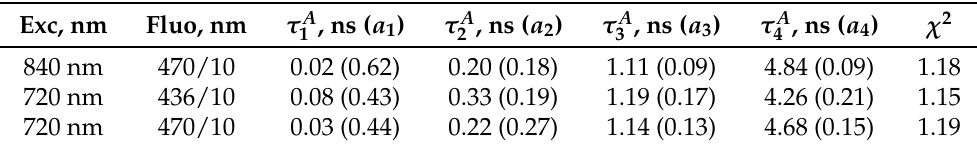
Table 3. Fluorescence decay times τ A using four-exponential model.